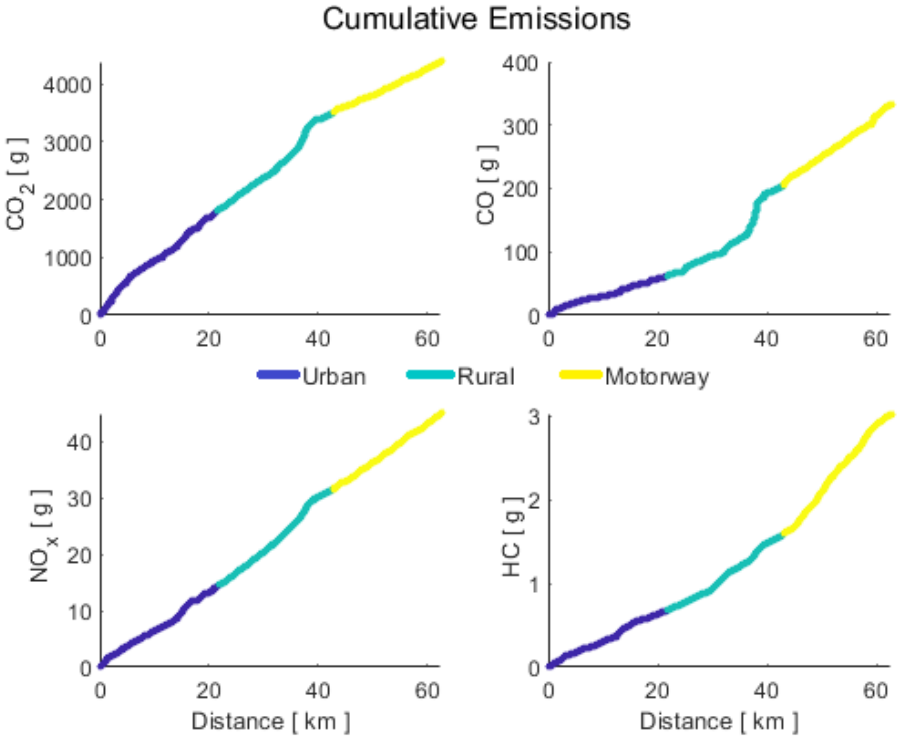
Figure 6. Cumulative emissions during RDE test.